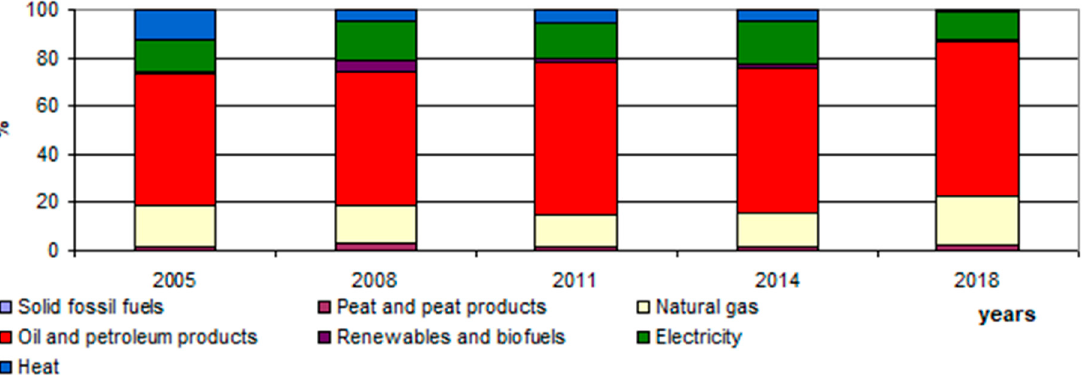
Figure 9. Structure of energy used in agriculture in Romania in 2005–2018.